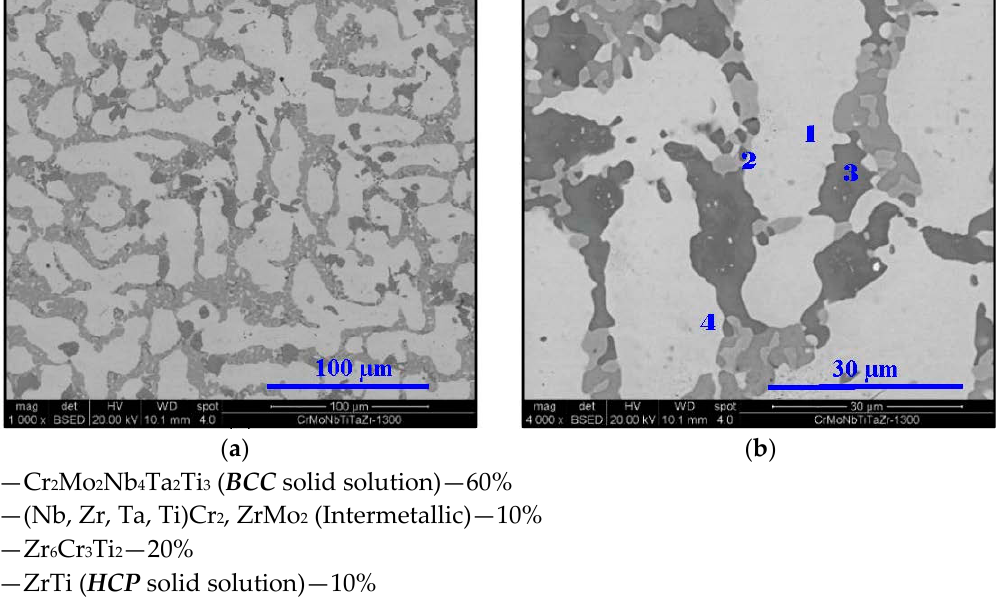
Figure 6 . SEM micrograph of Cr 20 Mo 10 Nb 20 Ta 10 Ti 20 Zr 20 at 1300 °C at ( a ) 1000× and ( b ) 4000× magnifications Figure 6. SEM micrograph of Cr 20 Mo 10 Nb 20 Ta 10 Ti 20 Zr 20 at 1300 ◦ C at ( a ) 1000 × and ( b ) 4000 × in BSE mode. magnifications in BSE